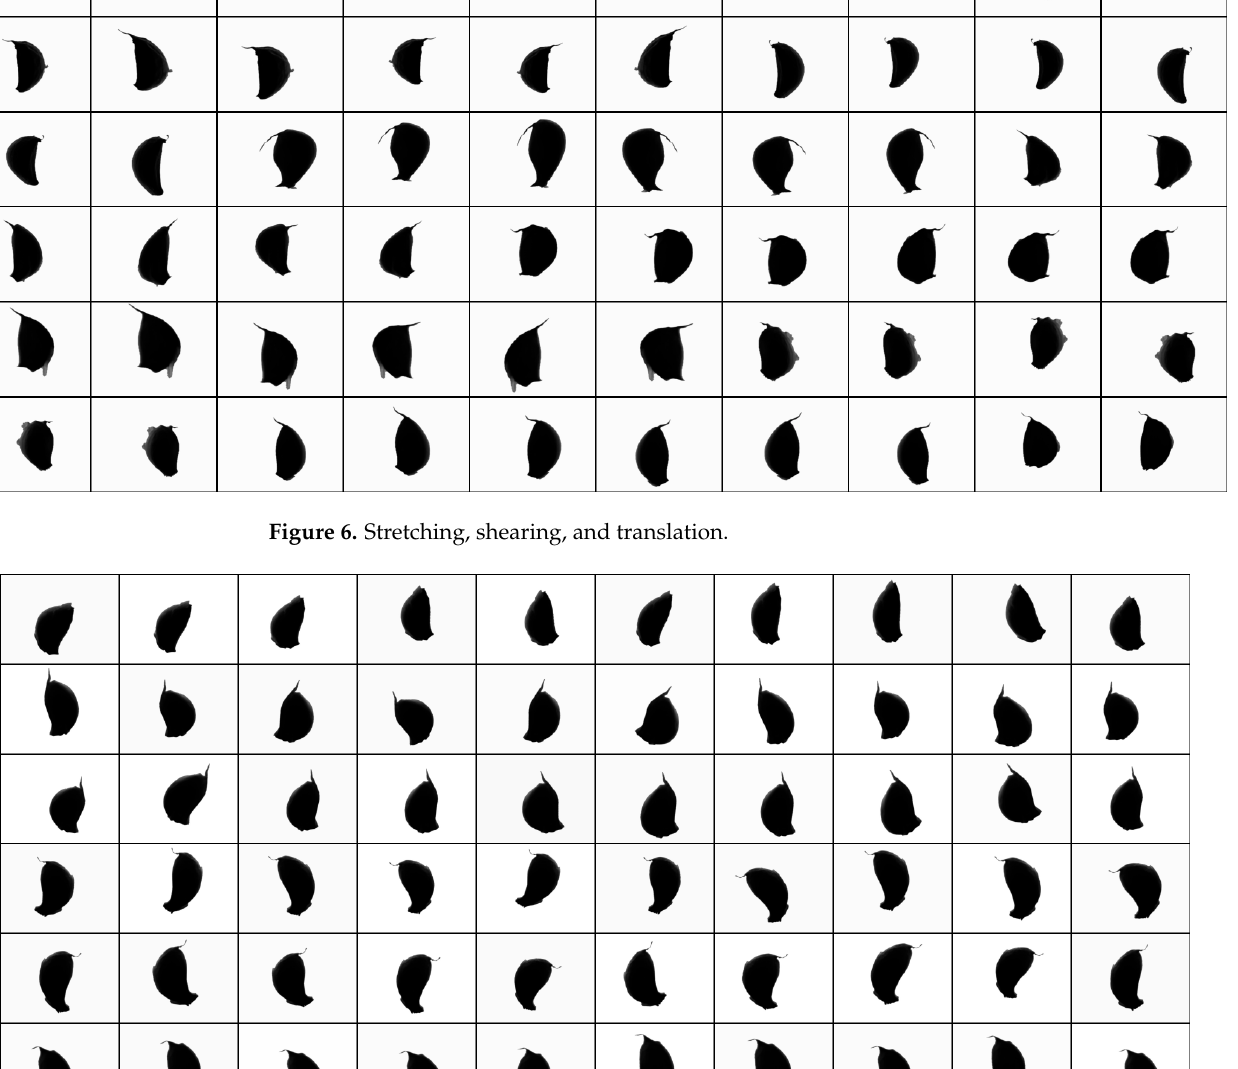
Figure 7. Image samples after rotation in the range of ± 30°.